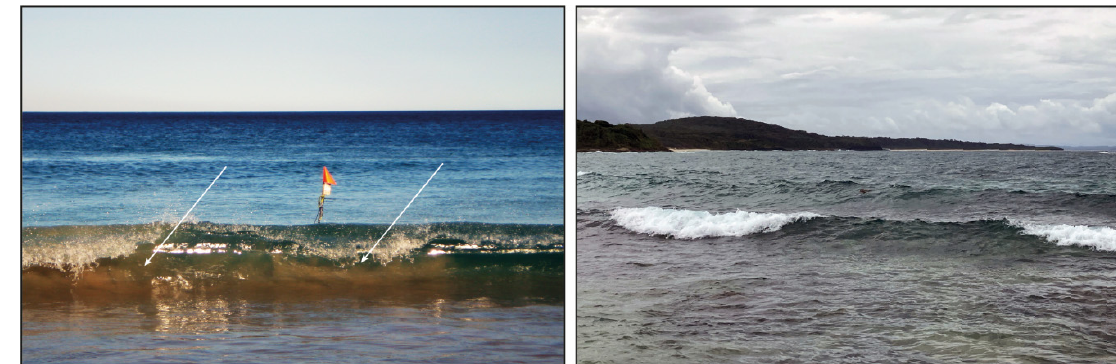
Figure 3. Photos of a plunging breaker ( left ) and a spilling breaker ( right ). The arrows in the left image point toward isolated sediment clouds lifted by the plunging breaker.